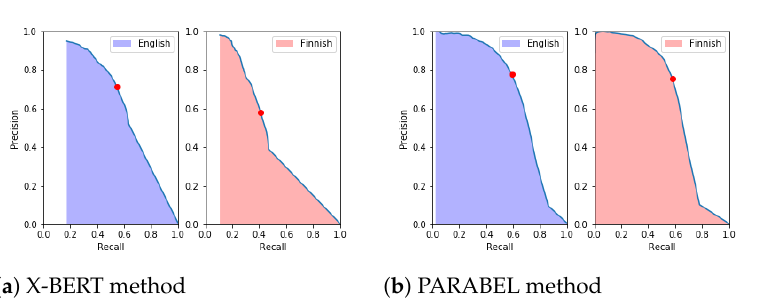
Figure 8. Precision-Recall curves obtained from the evaluation of X-BERT and Parabel methods where the red dots represent the corresponding maximum F1 score for each model.